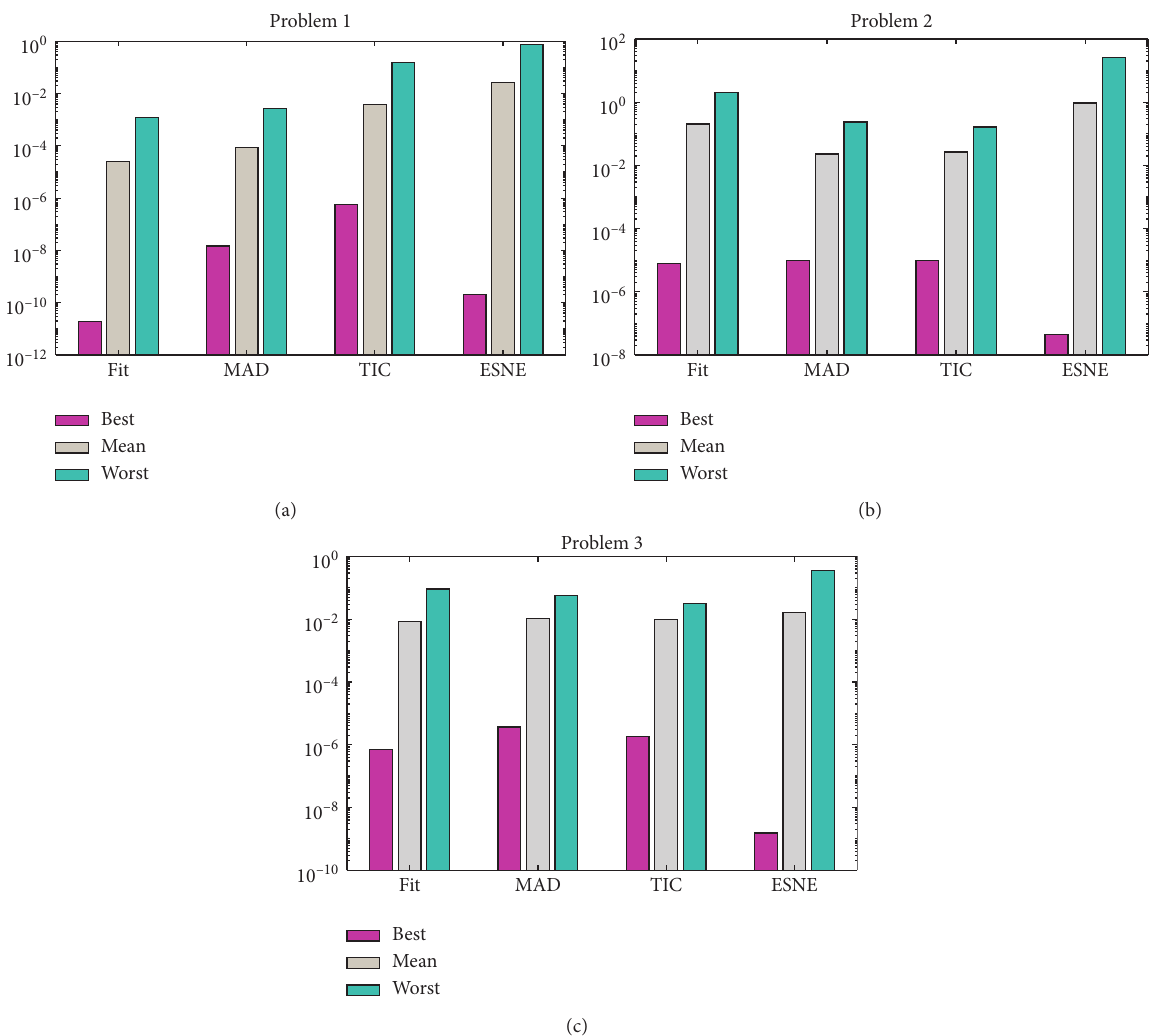
Figure 2: Performance measures for beam equations presented in Problems 1–3.